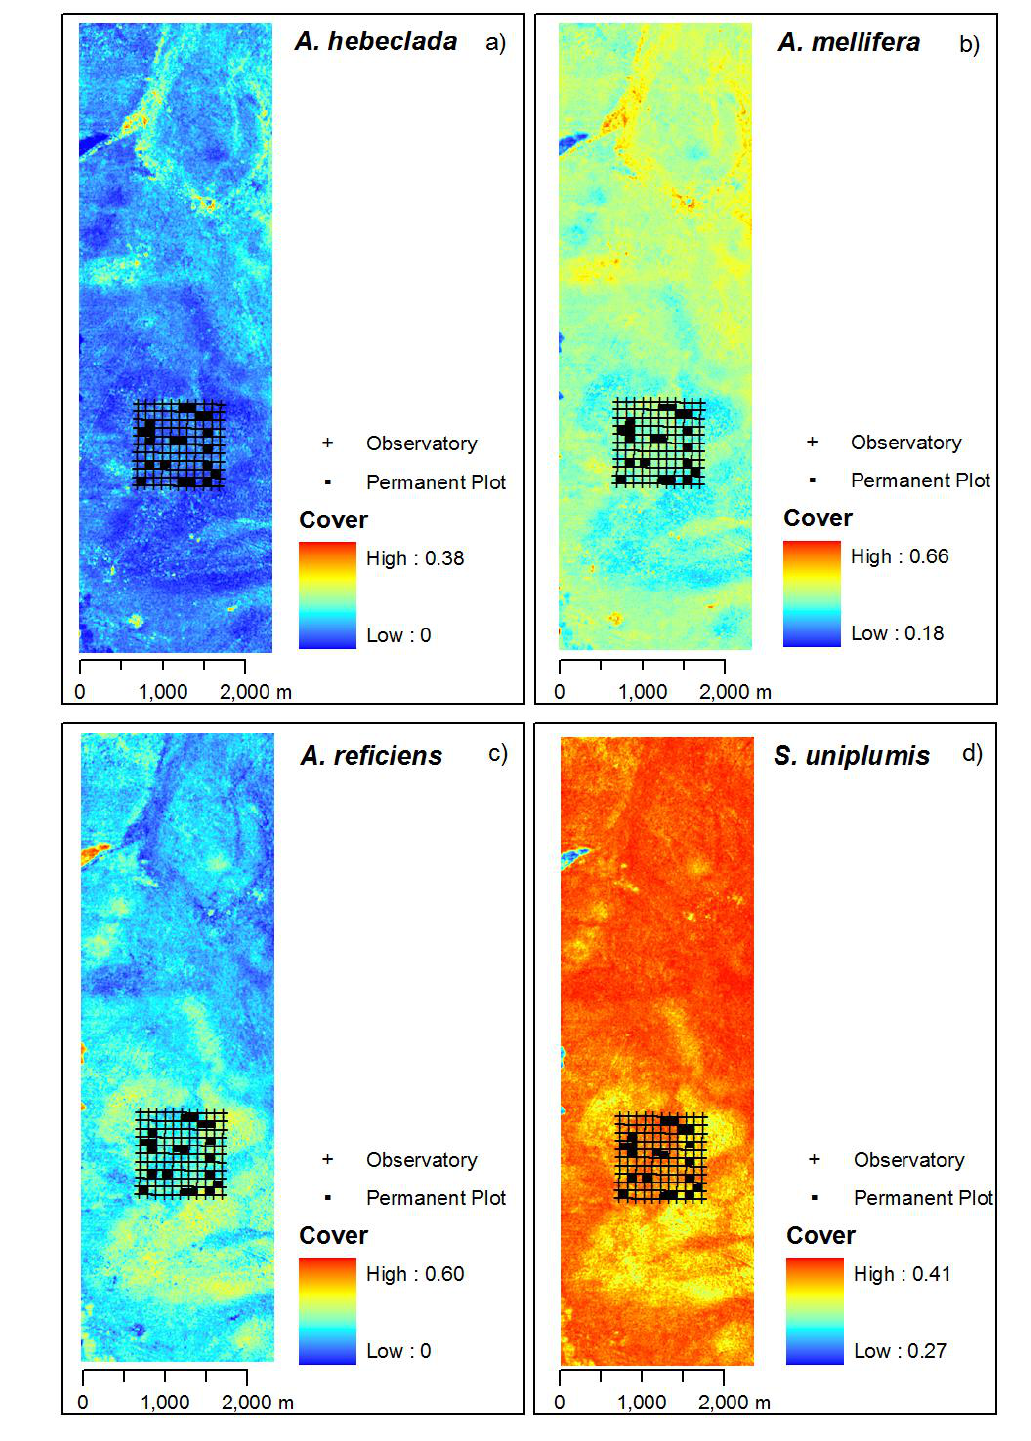
Figure 6. Predicted species cover maps of Hellinger-transformed cover values. Included are the positions of the permanent plot monitored by the BIOTA-Africa project, the source of the external validation dataset. Observatory marks the total covered area of 1 km 2 by the monitoring design. Images are stretched between minimum and maximum